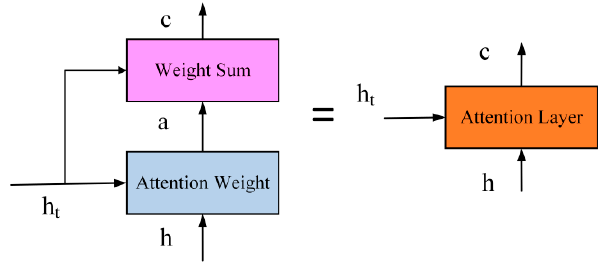
Figure 5. Attention operation depend on Bi-LSTM.